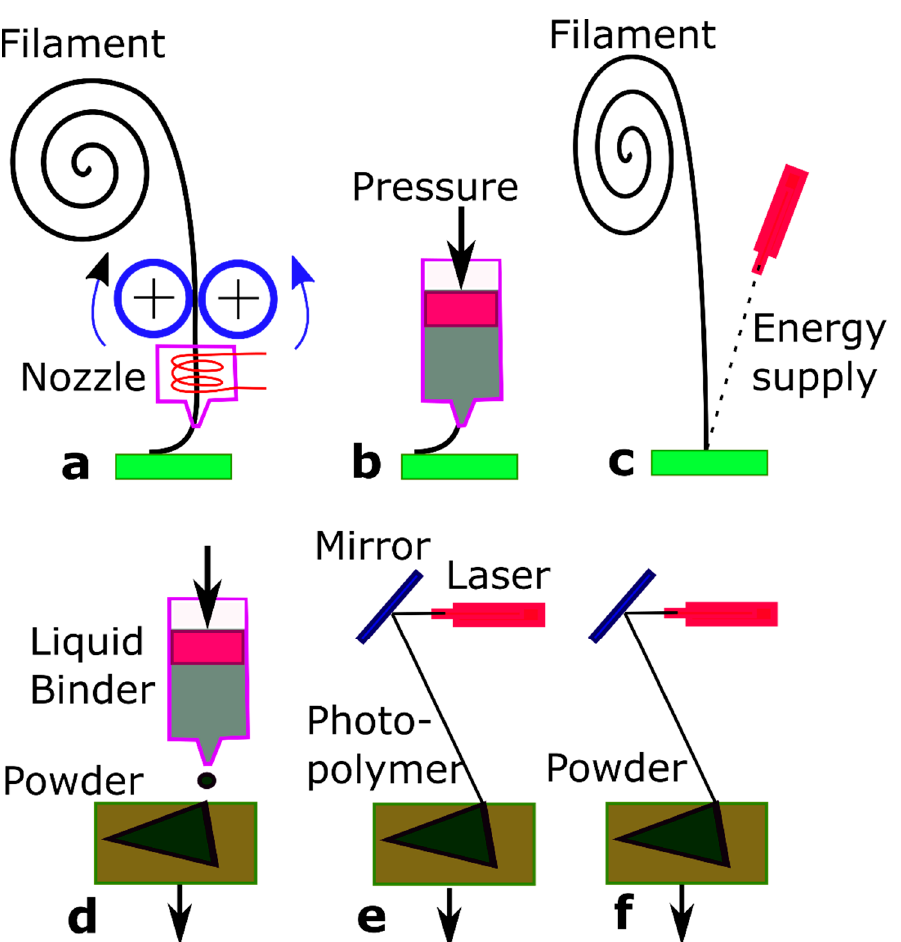
Figure 1. Principles of common additive manufacturing (AM) technologies: ( a ) fused deposition modeling (FDM), ( b ) direct ink writing (DIW), ( c ) directed energy based deposition ( d ) binder jetting process, ( e ) vat photo polymerization, ( f ) powder bed fusion with a laser sintering process.